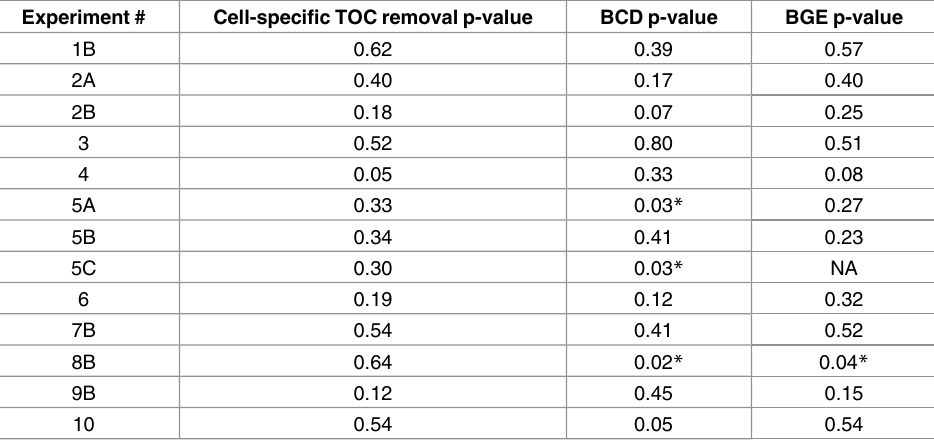
Table 2. P values for bacterioplankton carbon removaland growth